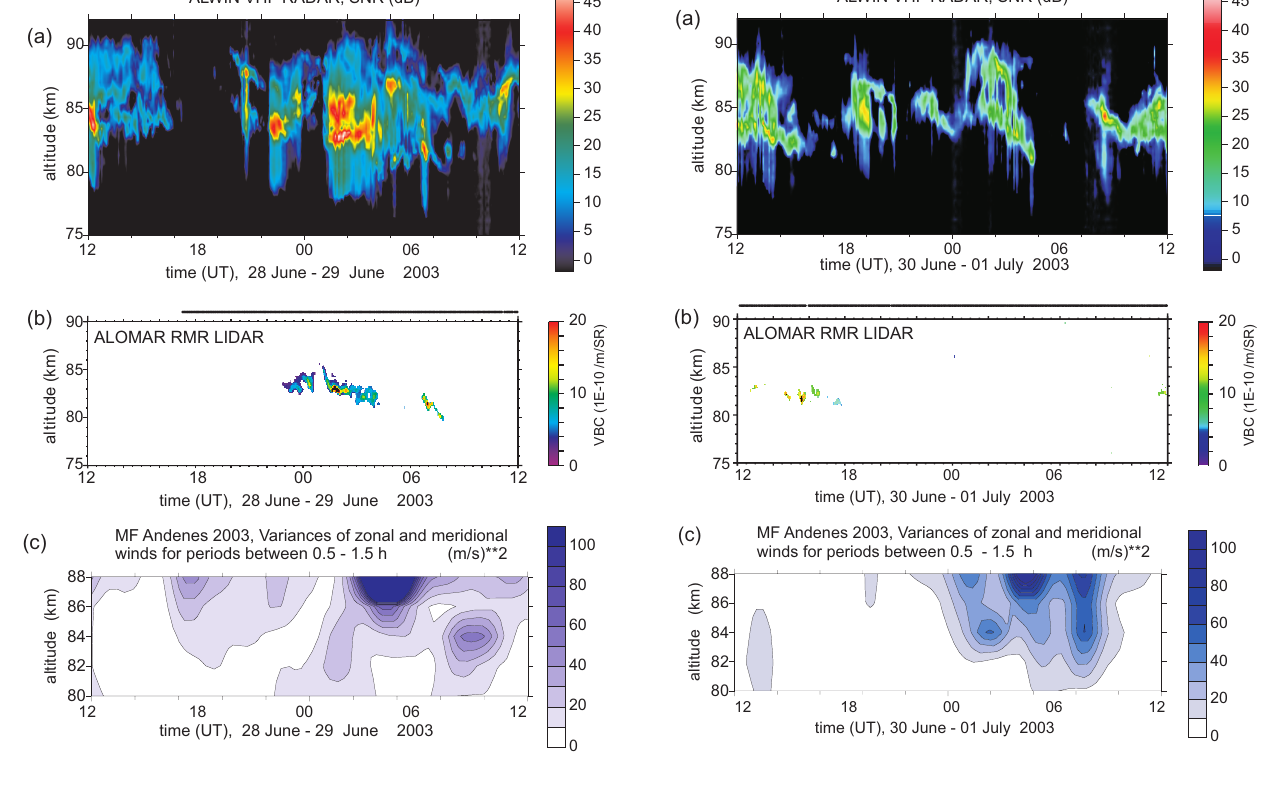
Fig. 11. Observations at Andenes from 28–29 June 2003: (a) PMSE observation with the ALWIN-VHF-Radar. (b) Signatures of NLC derived from simultaneous observations with the ALOMAR-RMR- lidar, represented by their volume backscatter coefficients. The line at the top indicates when lidar observations have been carried out. (c) Wind variances of gravity waves with period between 2–4h de- rived from the Andenes MF radar.